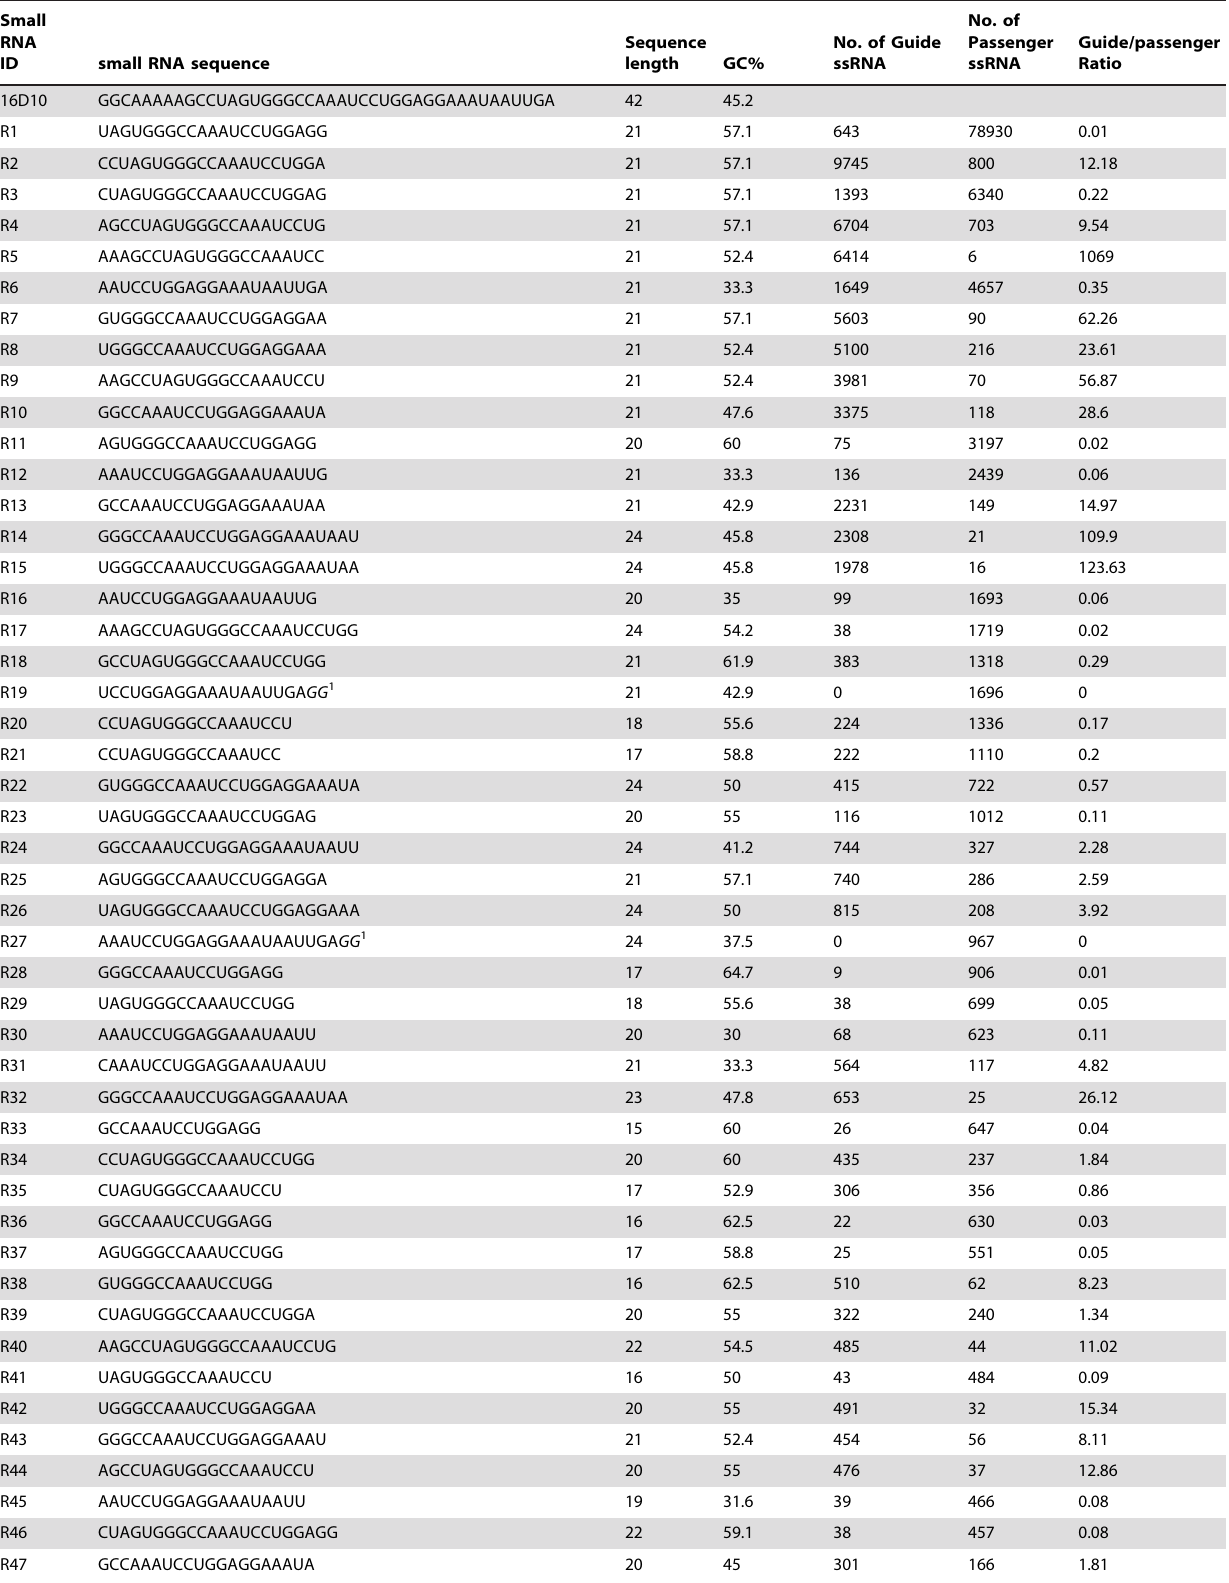
Table 2. Sequences, GC content and reads for the top 50 small RNAs from four pART27-42 hairy root lines.